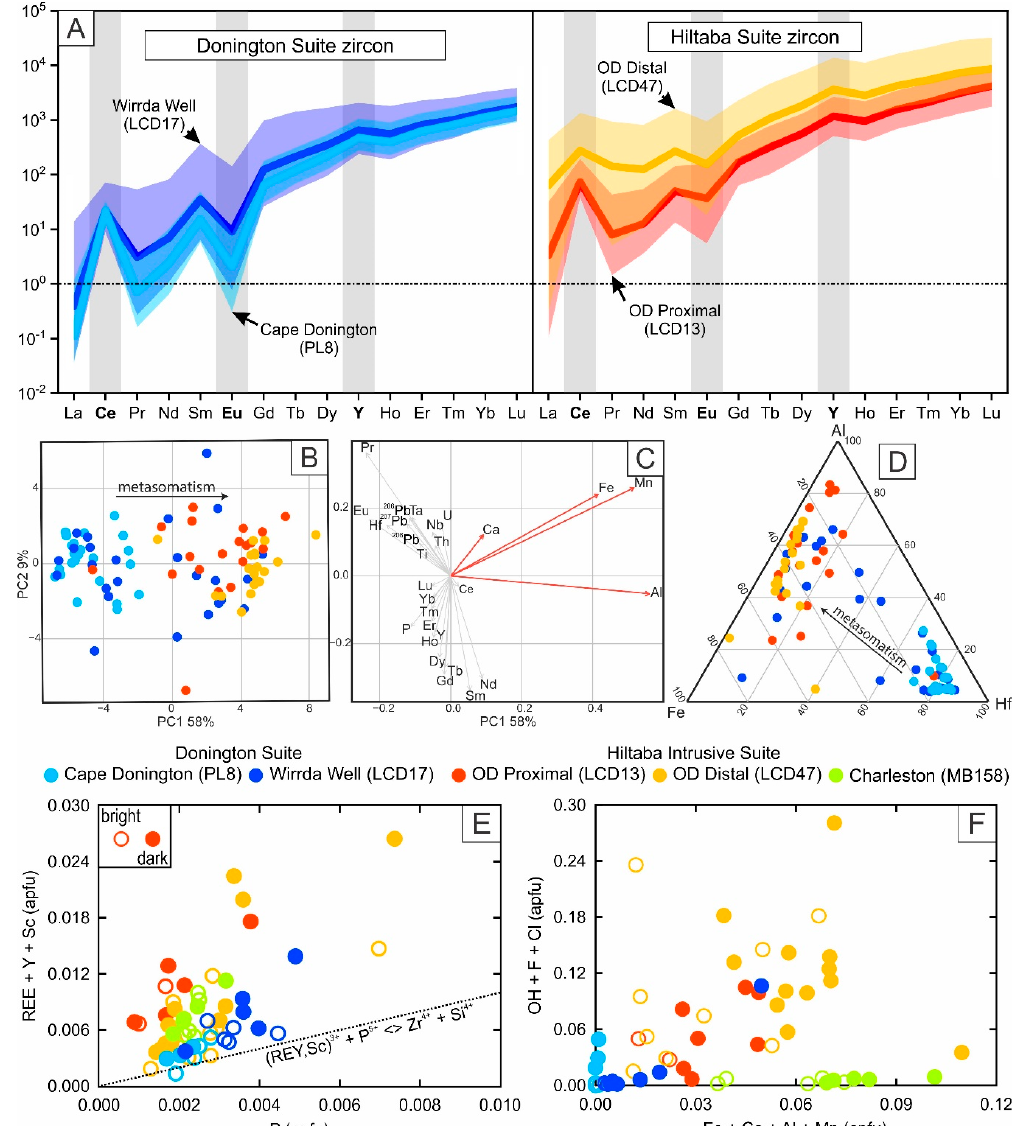
Figure 4. ( A ) LA-ICP-MS chondrite-normalized REY (REE + Y) fractionation trends for Donington Suite (light and dark blue) and Hiltaba Intrusive Suite (red and orange) samples. ( B and C ) PCA of LA-ICP-MS data, used to distinguish associated element signatures, and ( D ) a ternary Fe–Al–Hf diagram demonstrating the degree of zircon metasomatism (LA-ICP-MS data; Supplementary Materials B, Table S5). ( E ) Plot of (REY+Sc) 3+ versus P 5+ (EPMA data). ( F ) Plot of “non-formula” components Σ (Fe + Al + MnO + CaO) versus apfu Σ (OH + Cl + F), respectively. The EPMA diagrams 2 O 3 2 O 3 illustrate the relationship between substitution of both non-formulae elements and OH in zircon. Open and closed data points represent bright and dark bands in zircon, respectively; color codes correspond to samples in A – D (EPMA data; Supplementary Materials B, Table S4). See main text and Supplementary Materials A for additional